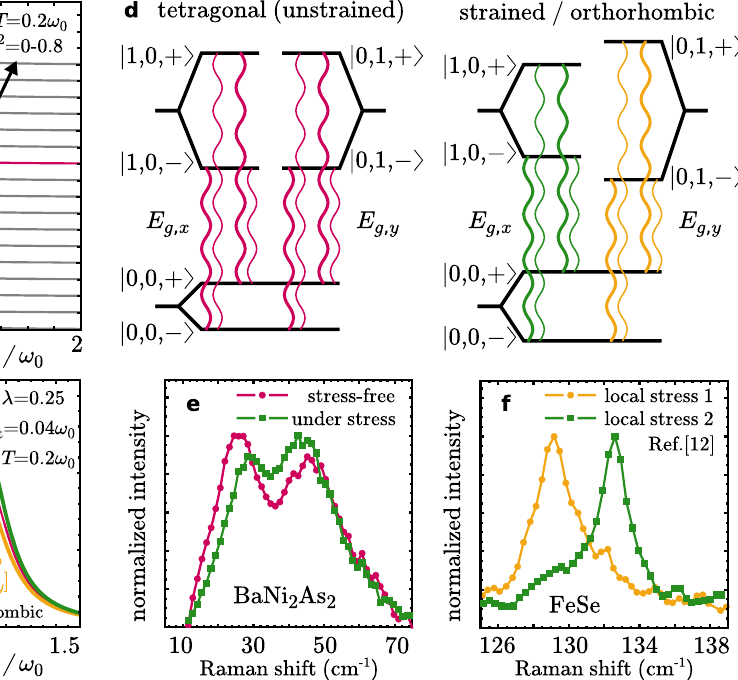
the degeneracy of the two Raman responses can be lifted by applying a conjugate external strain σ ext . d Schematic of the allowed transitions that cause the peak splitting of the Raman signal even in the tetragonal state (left panel) and in the strained/orthorhombicstate(rightpanel). e RamanresponseofBaNi 2 As 2 stress-free and under uniaxial stress and comparison to local stress dependence ( f ) of FeSe [Data from ref. 12, plotted with permission from the